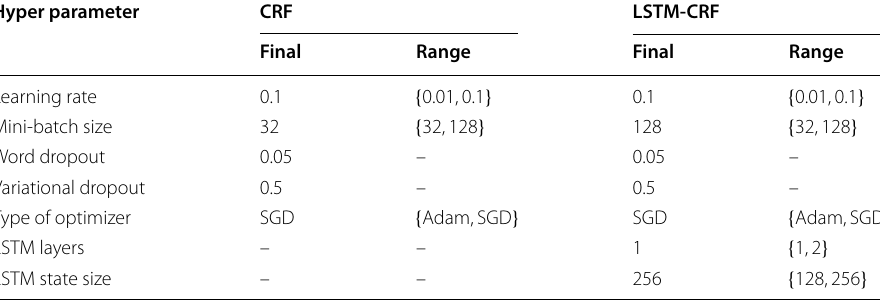
Table 4 Hyper-parameter search space and final values used Hyper parameter